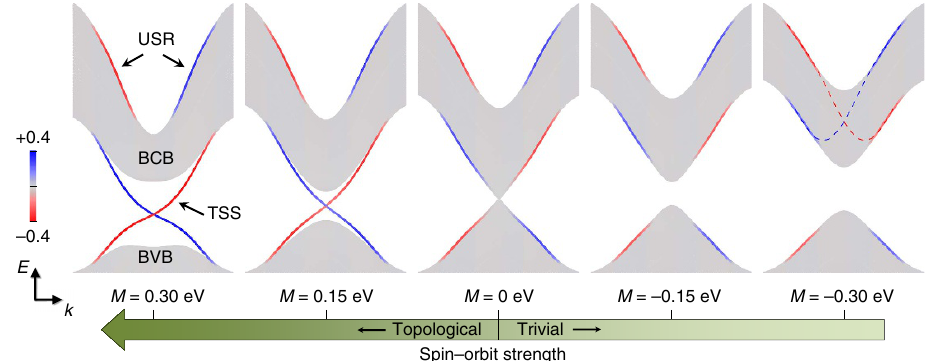
Figure 5 | Tight binding model calculation results. The colors represent the magnitude of the y -component of the polarization, so the unpolarized bulk-like bands appear in gray. The calculation on the left ( M ¼ 0.3eV) qualitatively captures the experimental observations of the topological surface state (TSS) and unoccupied surface resonance (USR). Moving right, the mass term M in the calculation is decreased to model a reduction in the spin-orbit interaction. These results show that the observed TSS and USR evolve into a trivial Rashba-pair through the process of band inversion. The dashed lines for M ¼ (cid:2) 0.3eV are a guide to the eye overlaid to show that the Kramer’s point of the Rashba-pair is buried in the bulk conduction band